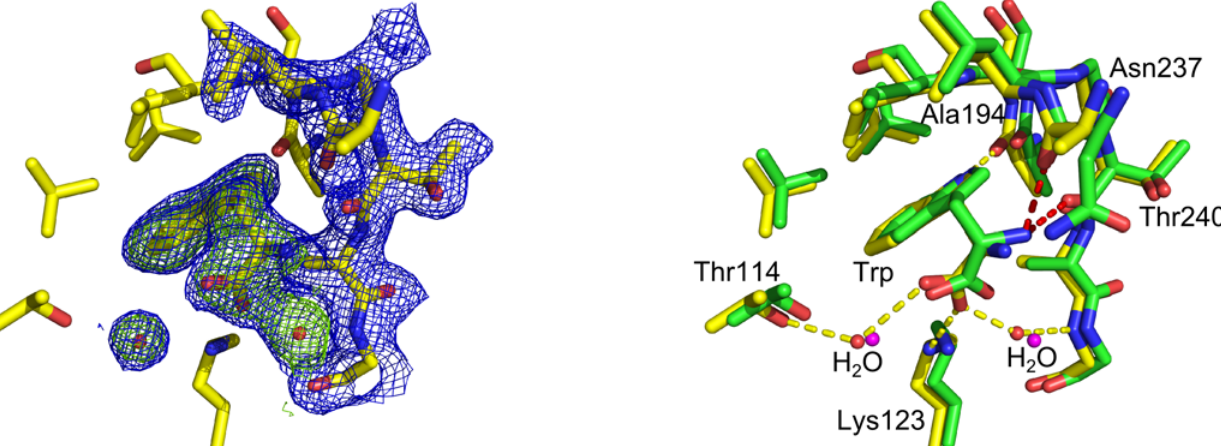
Fig 5. D -Trp in site 1. Left: Part of the electron density map in site 2 with D -Trp bound. The model conformation for the α 2b β 3-loop is in good agreement with the map (2 F o - F c map contoured at 1.0 σ (blue mesh) and F o - F c omit map contoured at 3.0 σ (green mesh)). Right: Comparison of binding mode of L -Trp (green sticks, water molecules shown as magenta spheres) and D -Trp (yellow sticks, water molecules shown as red spheres) in site 2. Key interactions of D - Trp are highlighted with yellow dashes. Red dashes indicate hydrogen bonds formed between the L -Trp amino group and Thr240 and Asn237. Due to the inversion of configuration, D -Trp does not establish a hydrogen bond to Thr240, and the hydrogen bonding interaction with Asn237 is of less optimal geometry compared to L